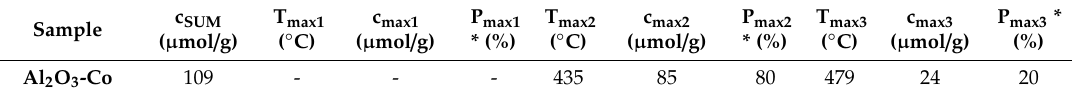
Table A4. Reducibility of cobalt catalyst determined by TPR.